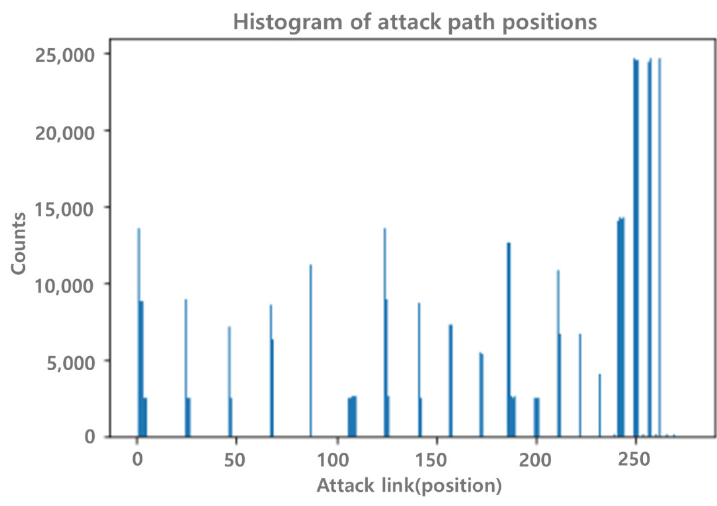
Figure 3. Histogram of attack path positions.